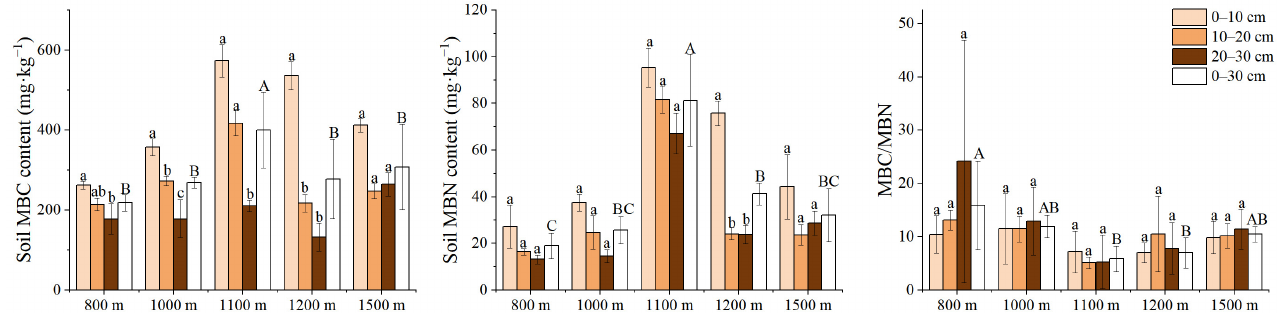
Figure 3. Variation characteristics of the soil’s MBC, MBN contents and MBC/MBN at different elevations. Different lowercase letters indicate significant differences between different soil layers at the same elevation gradient ( p < 0.05). Different capital letters indicate significant differences along different elevation gradients ( p < 0.05).